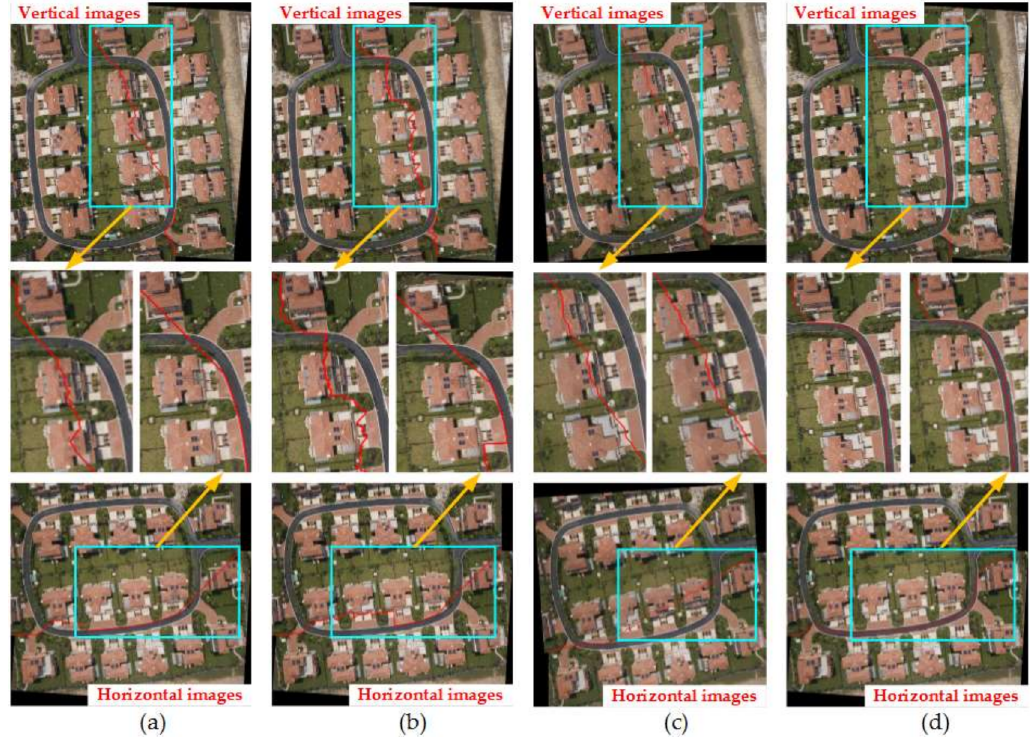
Figure 15. The seam-lines of four search methods under different situations for Figure 7d: ( a ) Dulapquet3-DP; ( b ) Dulapquet4-DP; ( c ) OpenCV-DP; ( d )